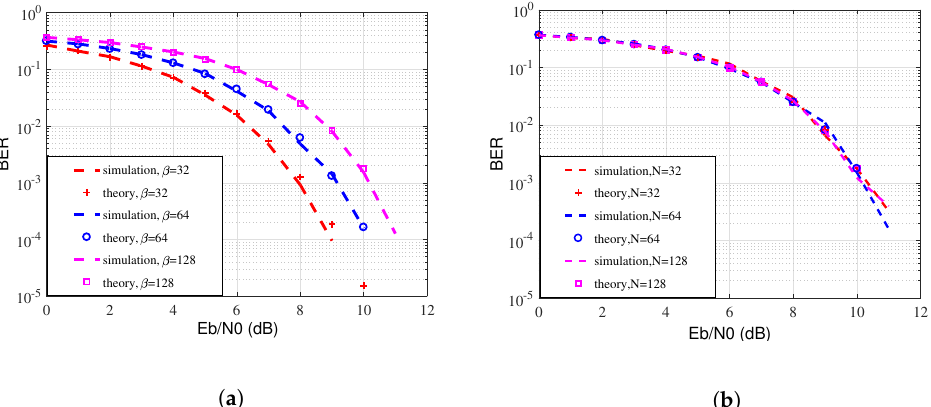
Figure 4. The theoretical and simulation BER of MIMO-FH-OFDM-DCSK system over the AWGN channel. ( a ) N = 64; ( b ) β = 64.